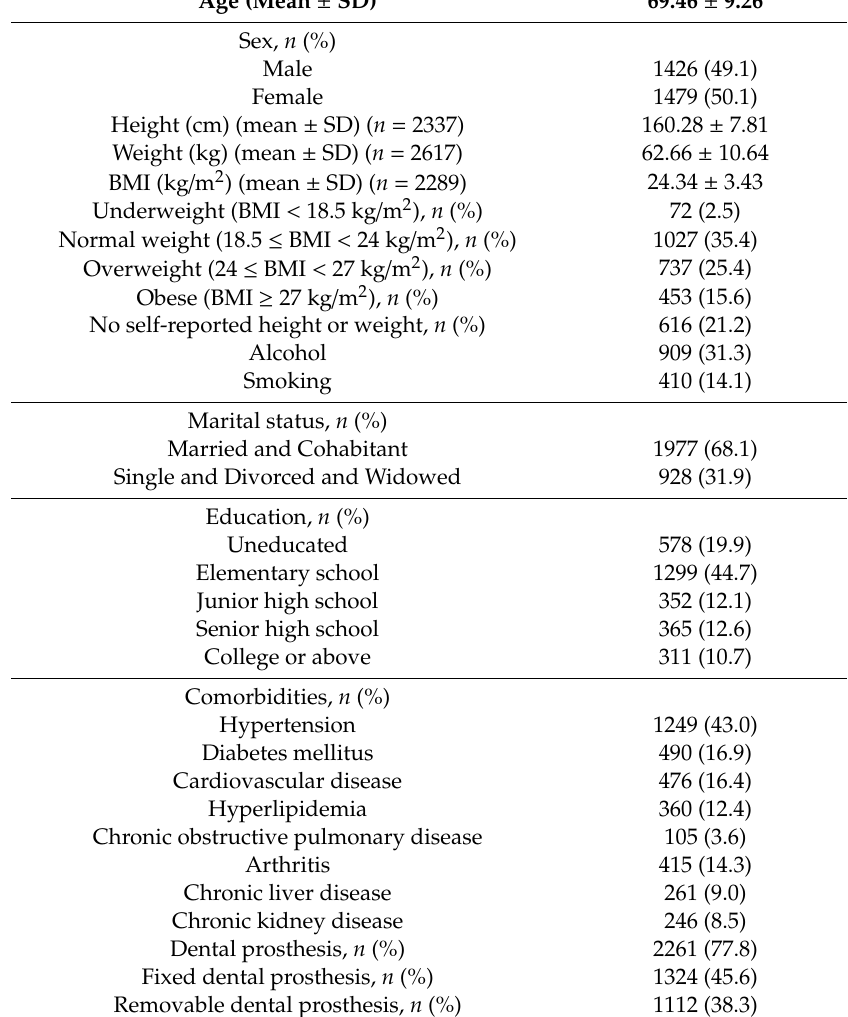
Table 1. Characteristics of the participants of the 2011 Taiwan Longitudinal Study on Aging (TLSA) ( n =